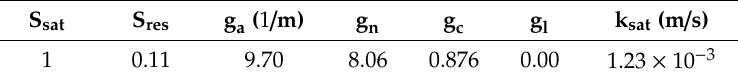
Table 2. Obtained parameters for the van Genuchten approximation for best fit to the results of the test by the evaporation method (HYPROP device) and the measured saturated hydraulic conductivity of the